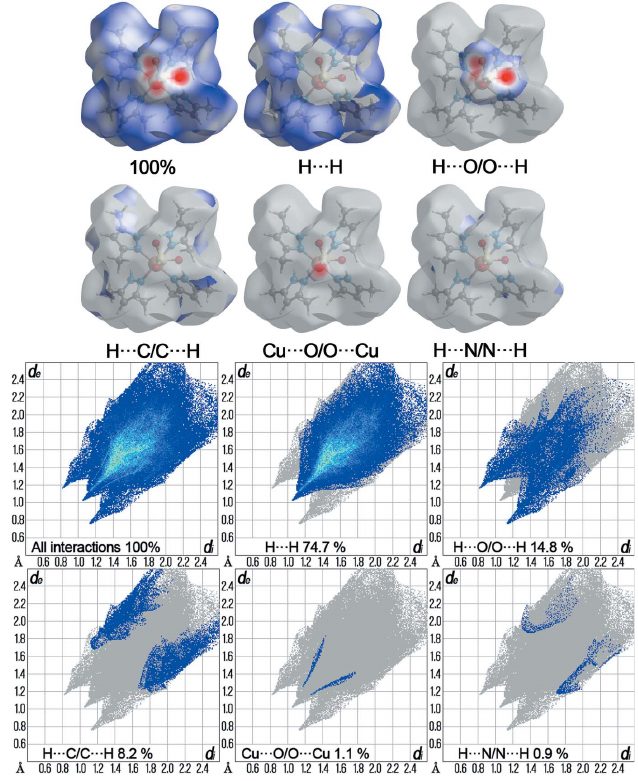
Figure 7 The overall two-dimensional fingerprint plot and those delineated into specified interactions. Hirshfeld surface representations with the function d norm plotted onto the surface for the different interactions.